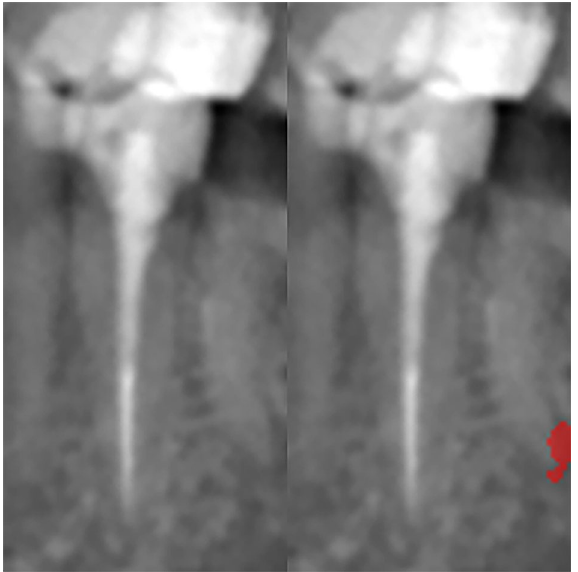
Figure 5. Incorrect periapical lesion localization mask at tooth 45. The lesion was predicted at the adjacent tooth